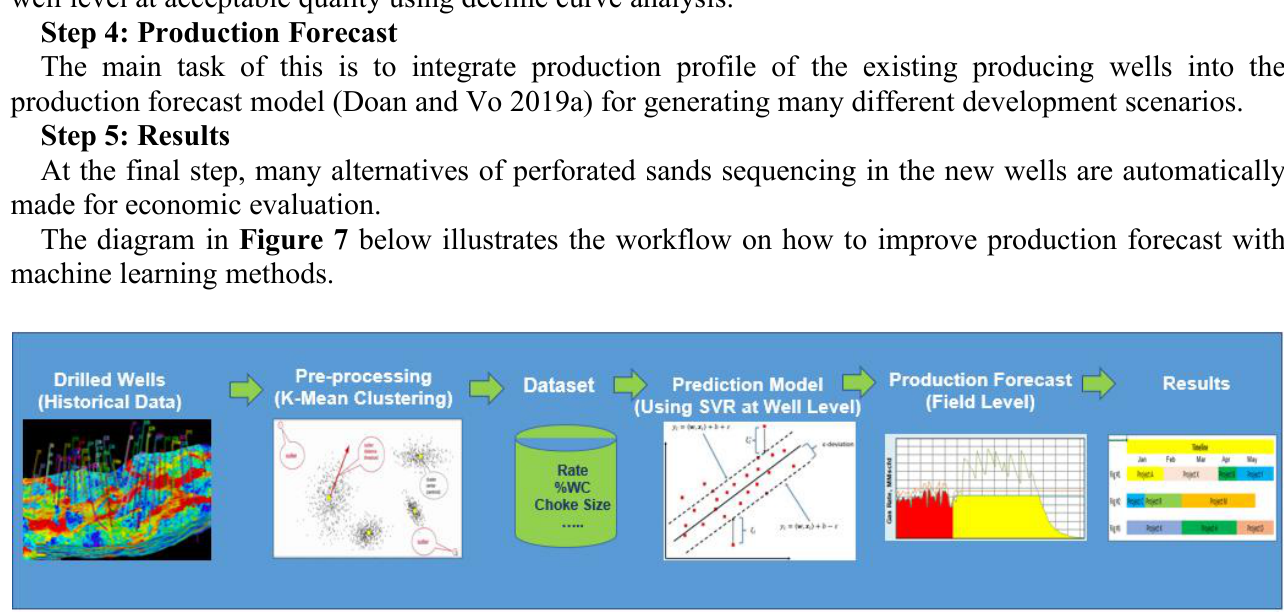
Figure 7—Workflow in the Application of Machine Learning to Improve Production